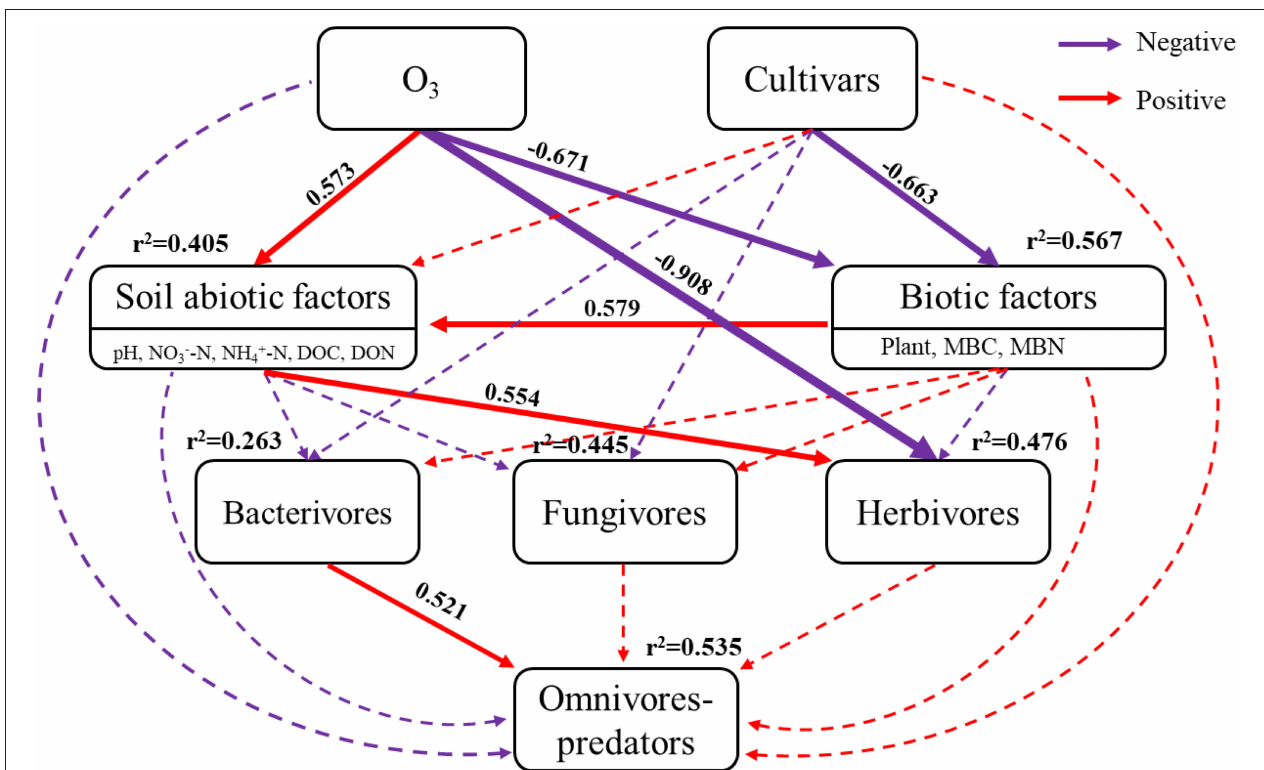
FIGURE 5 | Structural equation models (SEM) analysis of elevated ozone and rice cultivars on soil nematodes. The results of the model fitting: Chi-square ( χ 2 ) = 4.635, P = 0.704, df = 7, CFI (comparative fit index) = 1, RMSEA (root square mean error of approximation) < 0.001. Red and purple arrows showed positive and negative effects, while solid arrows and dashed arrows showed the directions and effects that were significant ( P < 0.05) and non-significant ( P > 0.05),